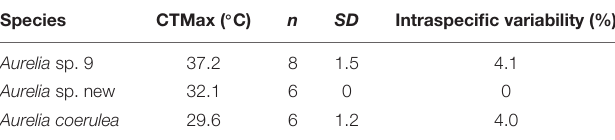
TABLE 3 | Critical Thermal Maximum (CTMax) values for three Aurelia